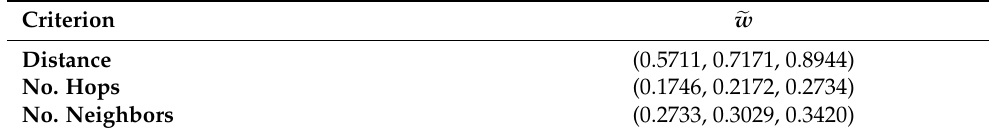
Table 7. Weighted matrix of criteria (cid:101) w from